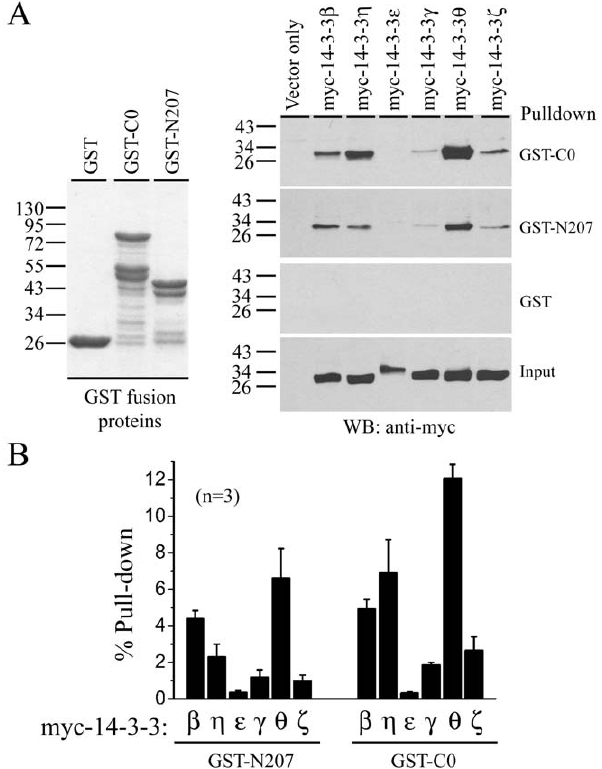
Figure 2. Isoform specificity of 14-3-3 binding with rEag1 N- and C-termini. ( A ) GST pull-down assay of cell lysates from HEK293T cells transfected with various myc-tagged 14-3-3 isoforms. ( Left panel ) Coomassie blue staining of the GST proteins. ( Right panel ) Immuno- blotting of pull-down products with the anti-myc antibody. Input volume shown at the bottom corresponds to 5% of the total cell lysates for pull-down. ( B ) Quantification of the pull-down efficiency of different 14-3-3 isoforms. The protein band intensities of individual myc-14-3-3 isoforms affinity precipitated by GST-N207 or GST-C0 in (A) were divided by those of cognate total inputs, thereby minimizing the potential bias conferred by the variation in protein expression among different 14-3-3 isoforms. Densitometric scans of immunoblots were obtained from three independent experiments.